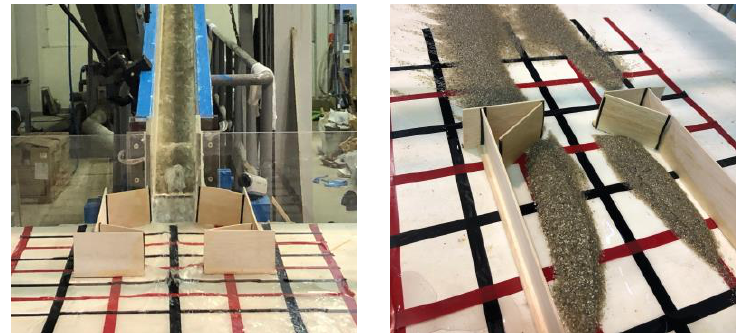
Figure 7. Experimental status ( left : experimental equipment, right : sediment control status).